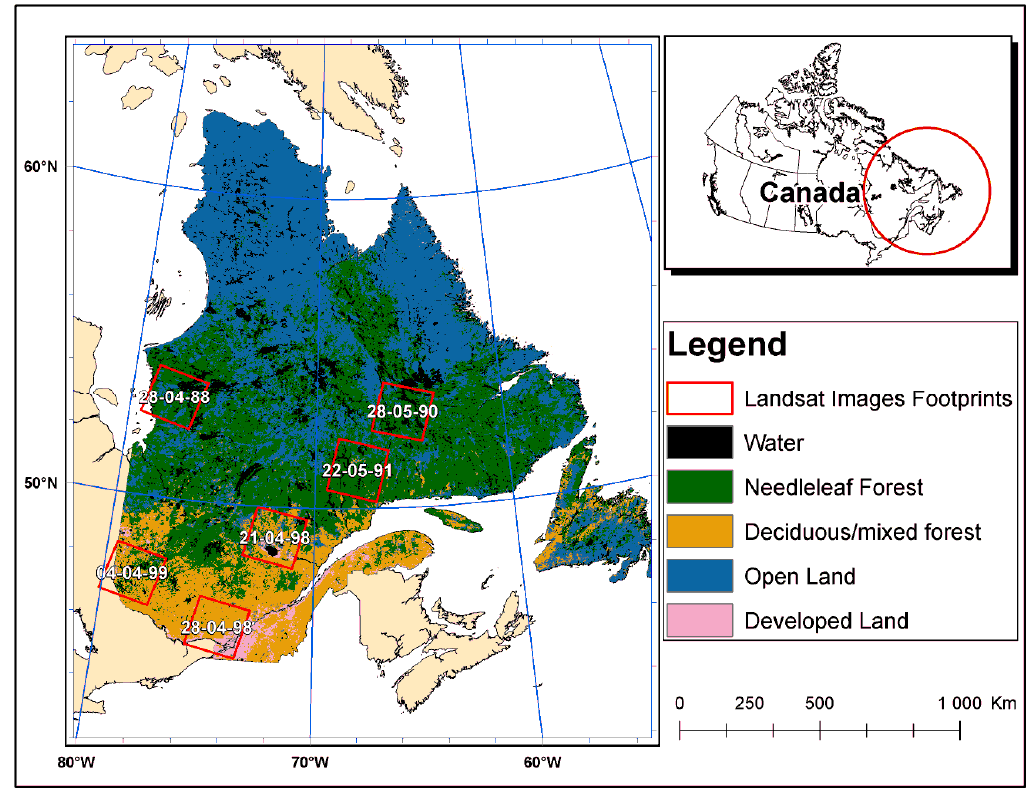
Figure 5. Location of the selected Landsat-TM